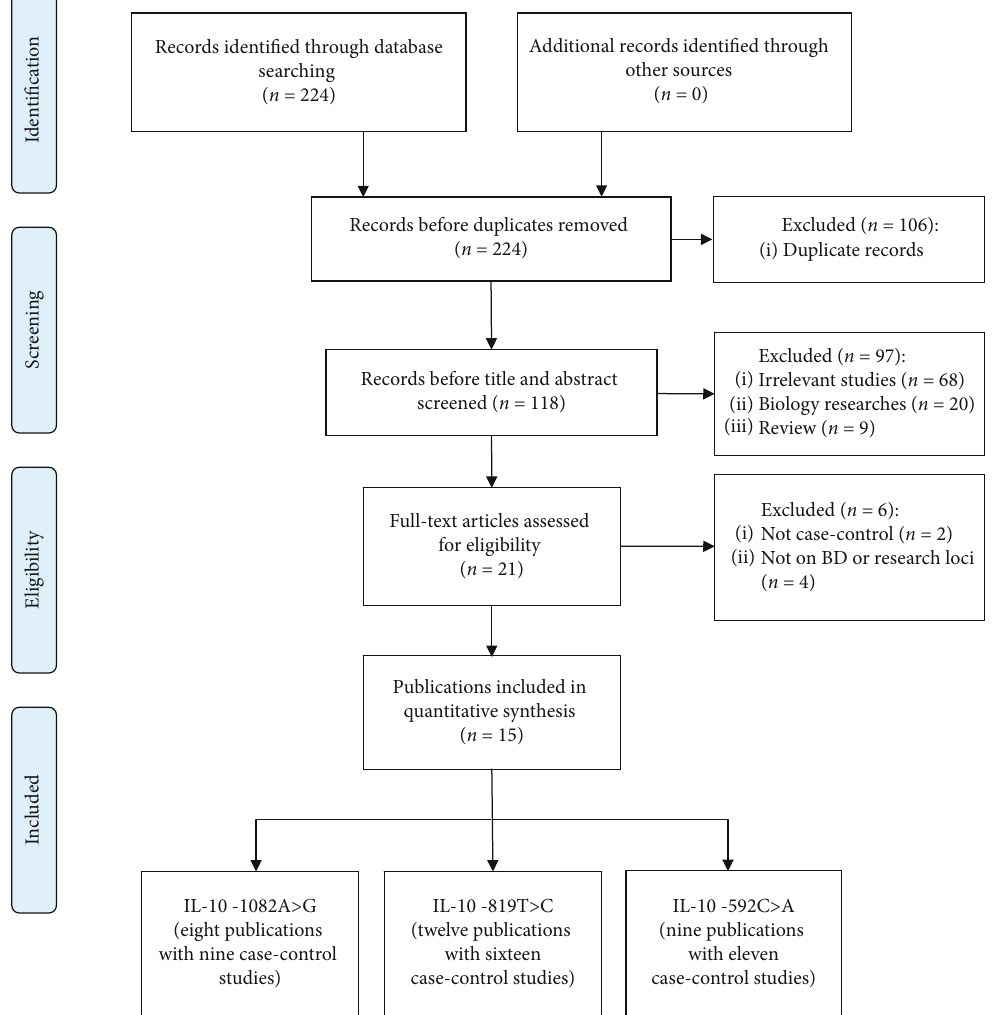
Figure 1: Flow diagram of the study selection